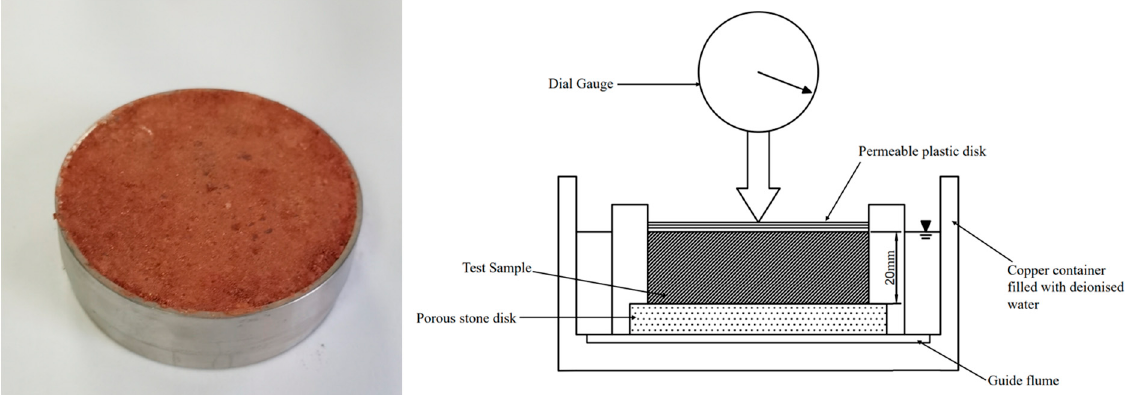
Figure 1. The specimen in the stainless steel ring ( left ) and schematic of the test setup used for the no loading swelling ratio test ( right ).